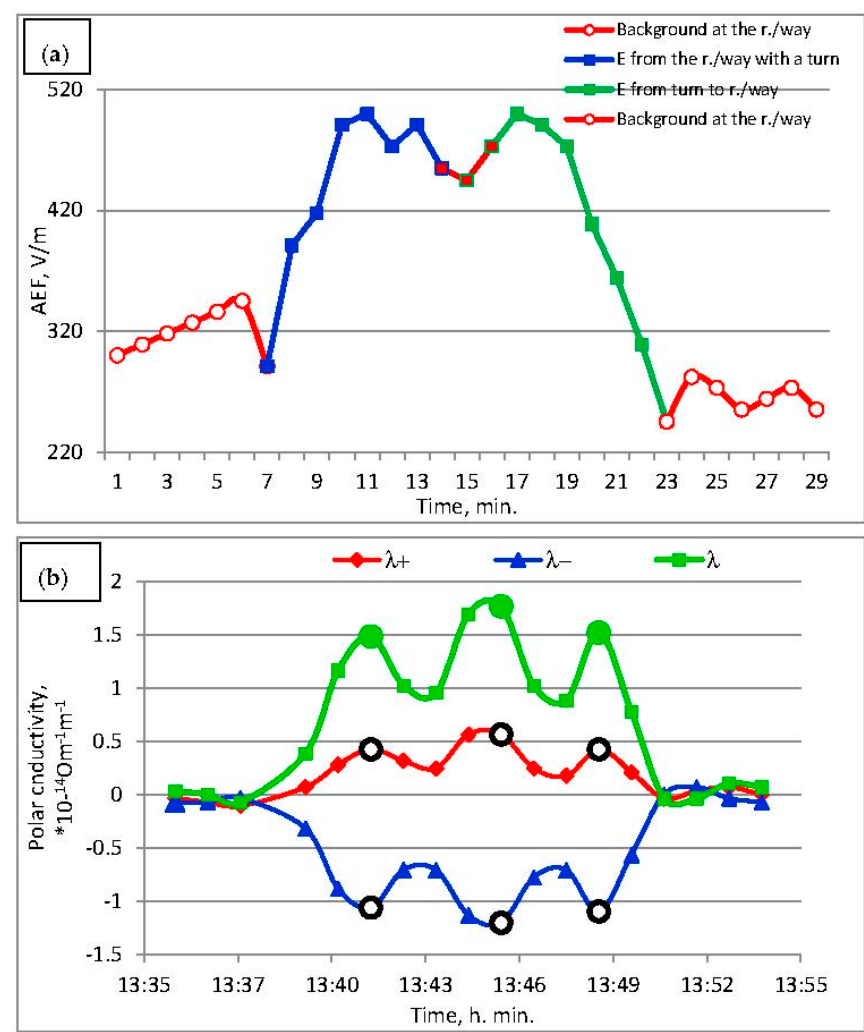
Figure 8. Background of the AEF near the railway; variations of AEF on the profile from the railway—E (from railway) and to the railway—E (to railway) ( a ); Temporal variations of positive, negative and total PC over the metro line. Intervals 13 h 35 m -13 h 39 m and 13 h 50 m -13 h 54 m —record zero level of the PC; 13 h 41 m , 13 h 45 m and 13 h 49 m - the passage of the metro trains under the observation picket( b